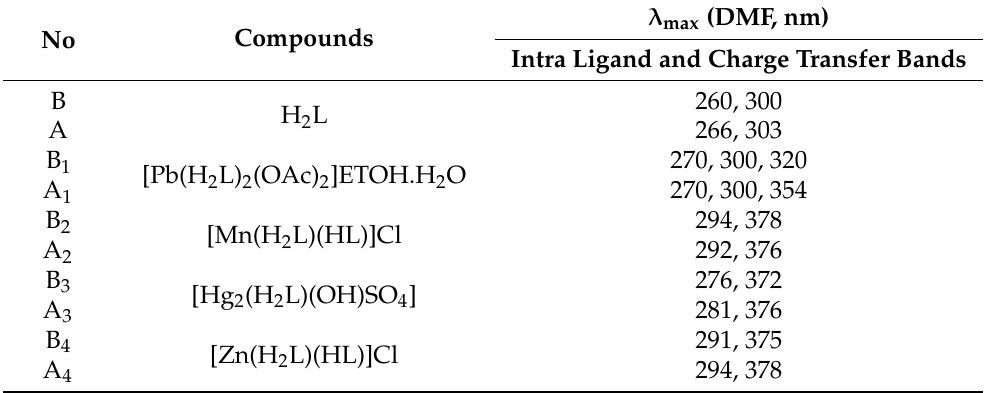
Table 3. Electronic spectral data λ max (nm) at room temperature of the ligand (H 2 L) and their metal complexes before and after